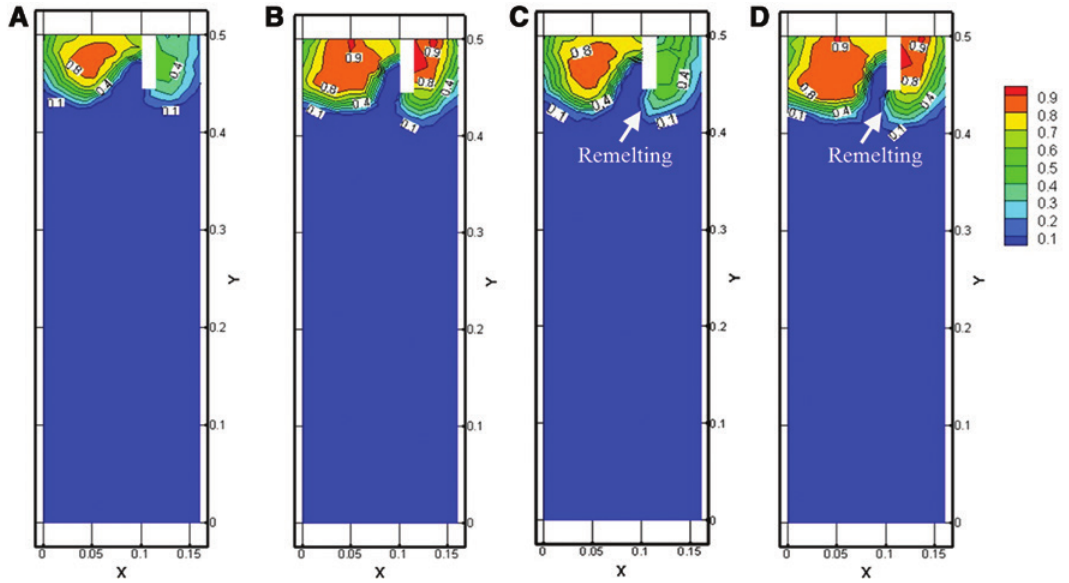
Figure 4: Influence of casting speed on the liquid fraction of clad slab: (A) symmetry plane, 70 mm·min -1 ; (B) sprues, 70 mm·min -1 ; (C) symmetry plane, 80 mm·min -1 ; (D) sprues, 80 mm·min -1